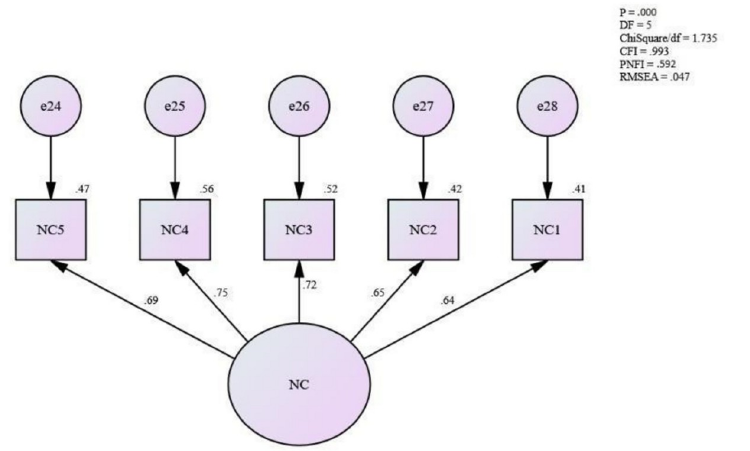
Fig 5. Measurement model for normative